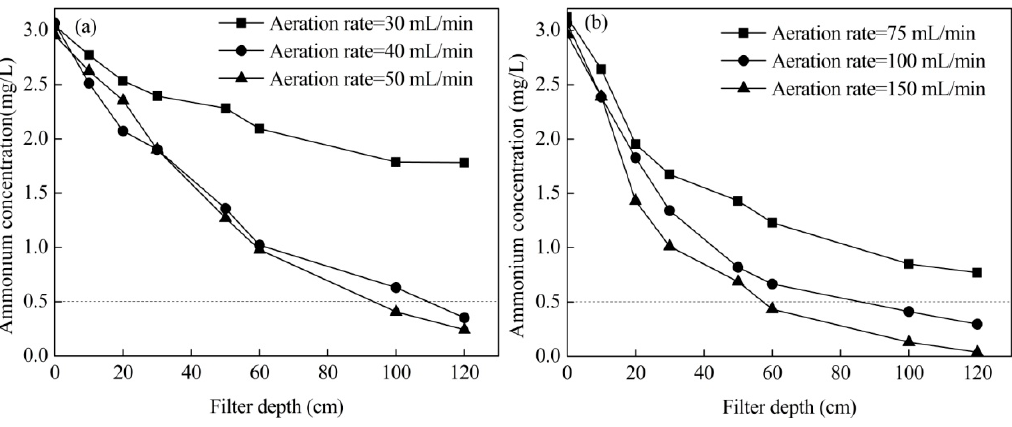
Figure 3. Ammonium removal with di ff erent aeration intensities: ( a ) pure oxygen and ( b ) compressed